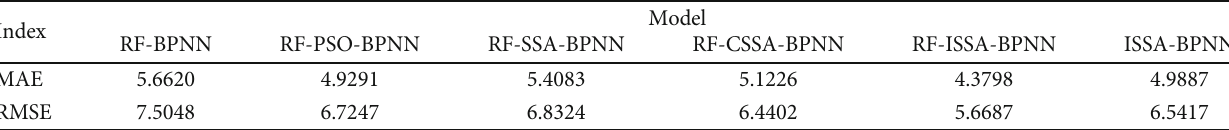
Table 6: Predicted results of 6